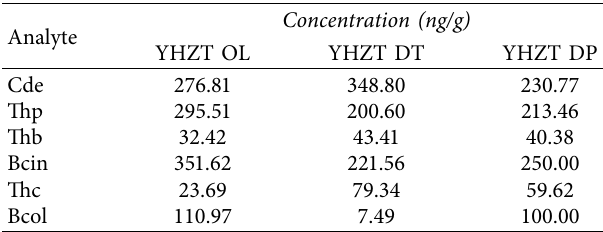
Figure 1: Chemical structures of the analytes and IS. Corydaline, Cde; tetrahydropalmatine, Thp; tetrahydroberberine, Thb; tetrahy- drocoptisine, Thc; byakangelicin, Bcin; byakangelicol, Bcol; promethazine hydrochloride, IS. Table 2: Optimized MS/MS transitions, cone and collision energy Table 3: The quantitative results of the six analytes in the three of the analytes and internal standards. different YHZT preparations.